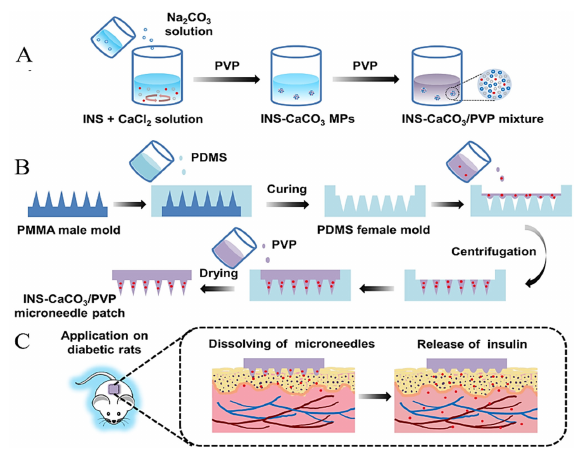
Figure 9. Schematic illustration of ( A ) preparation of INS-CaCO 3 MPs through precipitation method in the presence of PVP as surfactant; ( B ) fabrication process of INS-CaCO 3 /PVP MNs from PMMA male mold, and ( C ) application of INS-CaCO 3 /PVP MNs on diabetic rats for transdermal delivery of insulin. Reproduced with permission from [248], Elsevier, 2018. (INS: insulin; MPs: microparti- cles; PVP: polyvinylpyrrolidone; MNs: microneedles; PDMS: Poly(dimethylsiloxane); PMMA: polymethyl methacrylate). Drug administration through the skin is performed in order to treat skin diseases topically or for the transdermal absorption of drugs into the systemic circulation. Hydro- gels plays an important role in skin elasticity, moisturization and repair because they are not only capable of holding substantial amount of water, but also control the release of loaded drugs. This makes them suitable candidate for topical use (Figure 8C) [225]. For example, Ludovico et al. [249] designed and characterized a novel series of hybrid hydro- gels based on Alg and poly(vinyl) alcohol (PVA) for enhanced skin delivery of quercetin. The rheological analysis of quercetin-loaded hydrogels displayed pseudoplastic behavior, non-thixotropy and good resistance to deformation in the range of 20 °C to 40 °C. The hybrid hydrogel retained antioxidant activity of quercetin and facilitate its entry in the skin. These therapeutic hydrogels represent a potential topical transdermal drug delivery system for the treatment of skin ageing and inflammation. In other studies, Li et al. [250] fabricated a bioinspired Alg-gum Arabic hydrogel with micro/nanoscale structures to de- liver mitsugumin 53 (MG53), an essential component in cell membrane repair, for chronic wound healing. In vitro experiments showed that the hydrogel had a biphasic-kinetics release, which can facilitate both fast delivery of MG53 for improving the reepithelization process of the wounds as well as sustained release of the protein for treating the remod- eled phase of chronic wounds. In vivo mouse model experiments confirmed that the hy- drogel encapsulated within rhMG53 could promote dermal wound healing and suppress scarring without adverse inflammation and abnormality of major organs. Zohreh et al. [251] packed hesperidin in Alg/chitosan hydrogel as an efficient method for wound heal- ing. The hydrogels possess appropriate porosity (91.2 ± 5.33%) with the interconnected pores and could degrade almost 80% after 14 days. In vitro results revealed the hydrogels have no toxicity on 3T3 murine fibroblast cells and the negative effect on Staphylococcus